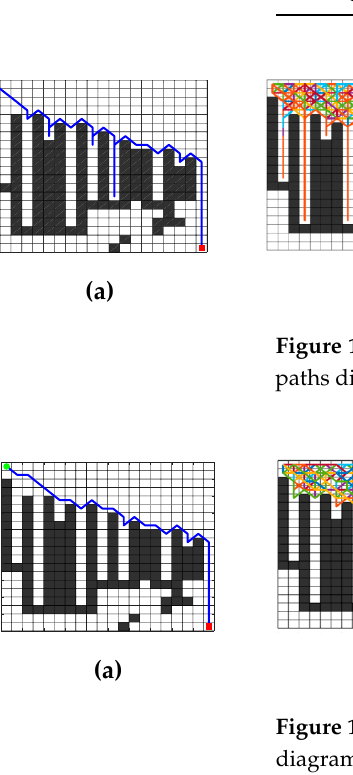
(d) Figure 15. Diagram of the optimal path of this paper; ( a ) Optimal path diagram; ( b ) All ants’ paths diagram; ( c ) Iterative diagram of the optimal path; and ( d ) Iterative diagram of ants’ paths. The simulation results show that the retraction strategy preserves all the ants’ solu- tions. Still, the ants move forward and backward repeatedly in the deadlocked region, leaving a large amount of interference pheromone for subsequent ants. The pathfinding ability of ants becomes worse and worse as the iteration progresses, showing that the re- traction strategy is not suitable for the large-scale trap environment. Although the death strategy is more effective than the retraction strategy in terms of path length and iteration, the number of ants that died due to deadlock before the algorithm achieved convergence is as high as 35.8%, negatively impacting the ability to solve the optimal solution. The death strategy can achieve better paths than the retraction strategy, but it is trapped in a local optimum and cannot be improved by changing the pheromone volatility factor any- more. This paper enhances the algorithm based on the advantage of the retraction strat- egy, which can preserve ants’ survival and improve the solution effect. From the experi- mental results, the ants in this paper retreat from the deadlocked region in time and add a virtual barrier grid to the deadlocked area to prevent subsequent ants from falling into this part, which improves the path search quality of the following ants. Our strategy can obtain better paths in large-scale deadlock environments, and the search time is also shorter, which is more suitable for path planning of mobile robots in a complex environ- ment. 6.2. Simulation Experiment Analysis of IACO A general environment of 20 × 20 scale and a U-shaped environment are chosen for comparison experiments, with a population of 50 ants and the number of iterations set to 50. 6.2.1. General Environment To verify the effectiveness and superiority of our IACO, the traditional ACO, algo- rithms from Luo et al. [12], and Dai et al. [13] are selected for comparative experimental analysis in a conventional environment that is based on Luo et al. [12]. The results of the simulation experiments are shown in Table 4 and Figure 16, where: the black dashed line in Figure 16a is the initial path of our algorithm, the blue dashed line is the path after optimizing the redundant nodes, and the solid red line is the path of three times B-sample